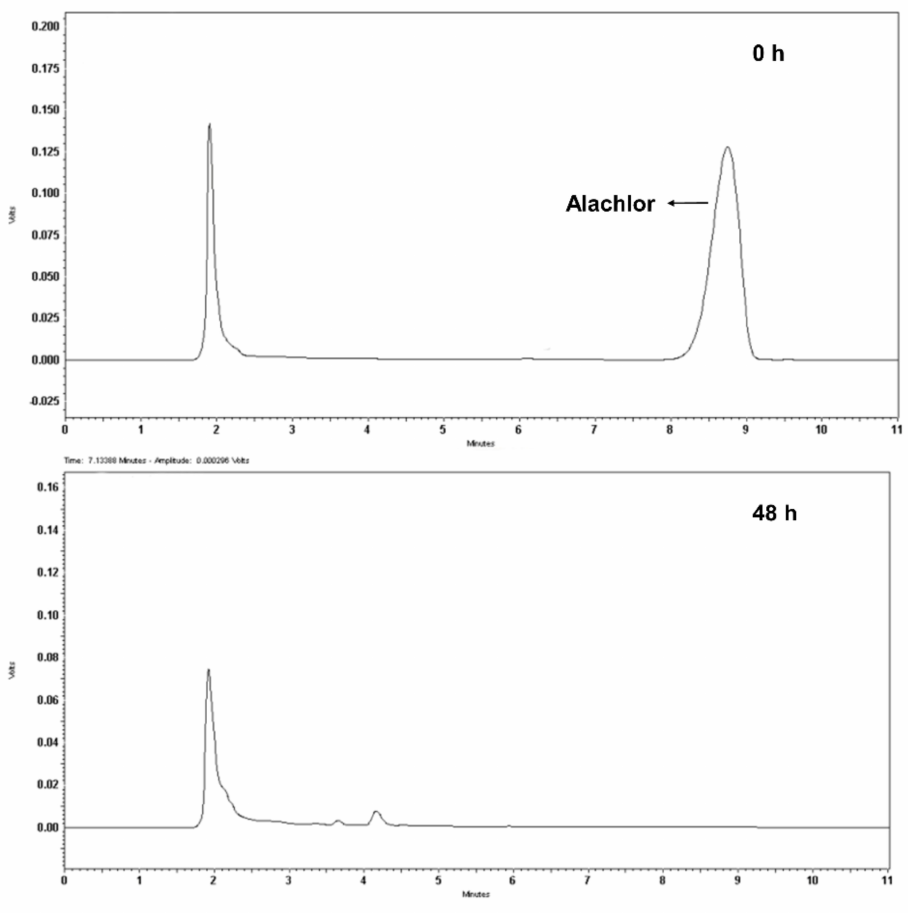
Figure 4. HPLC spectrum obtained from the culture at 0 h and 48